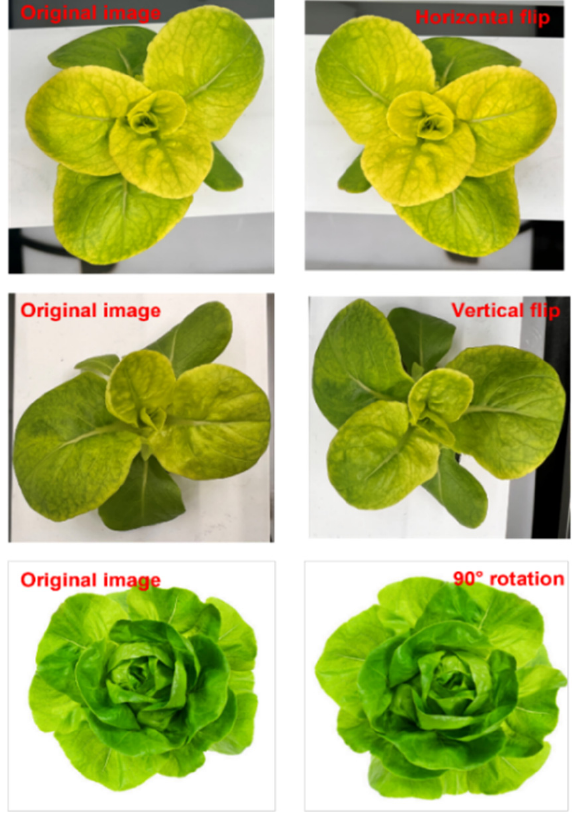
Figure 3. Data augmentation was performed on different images.